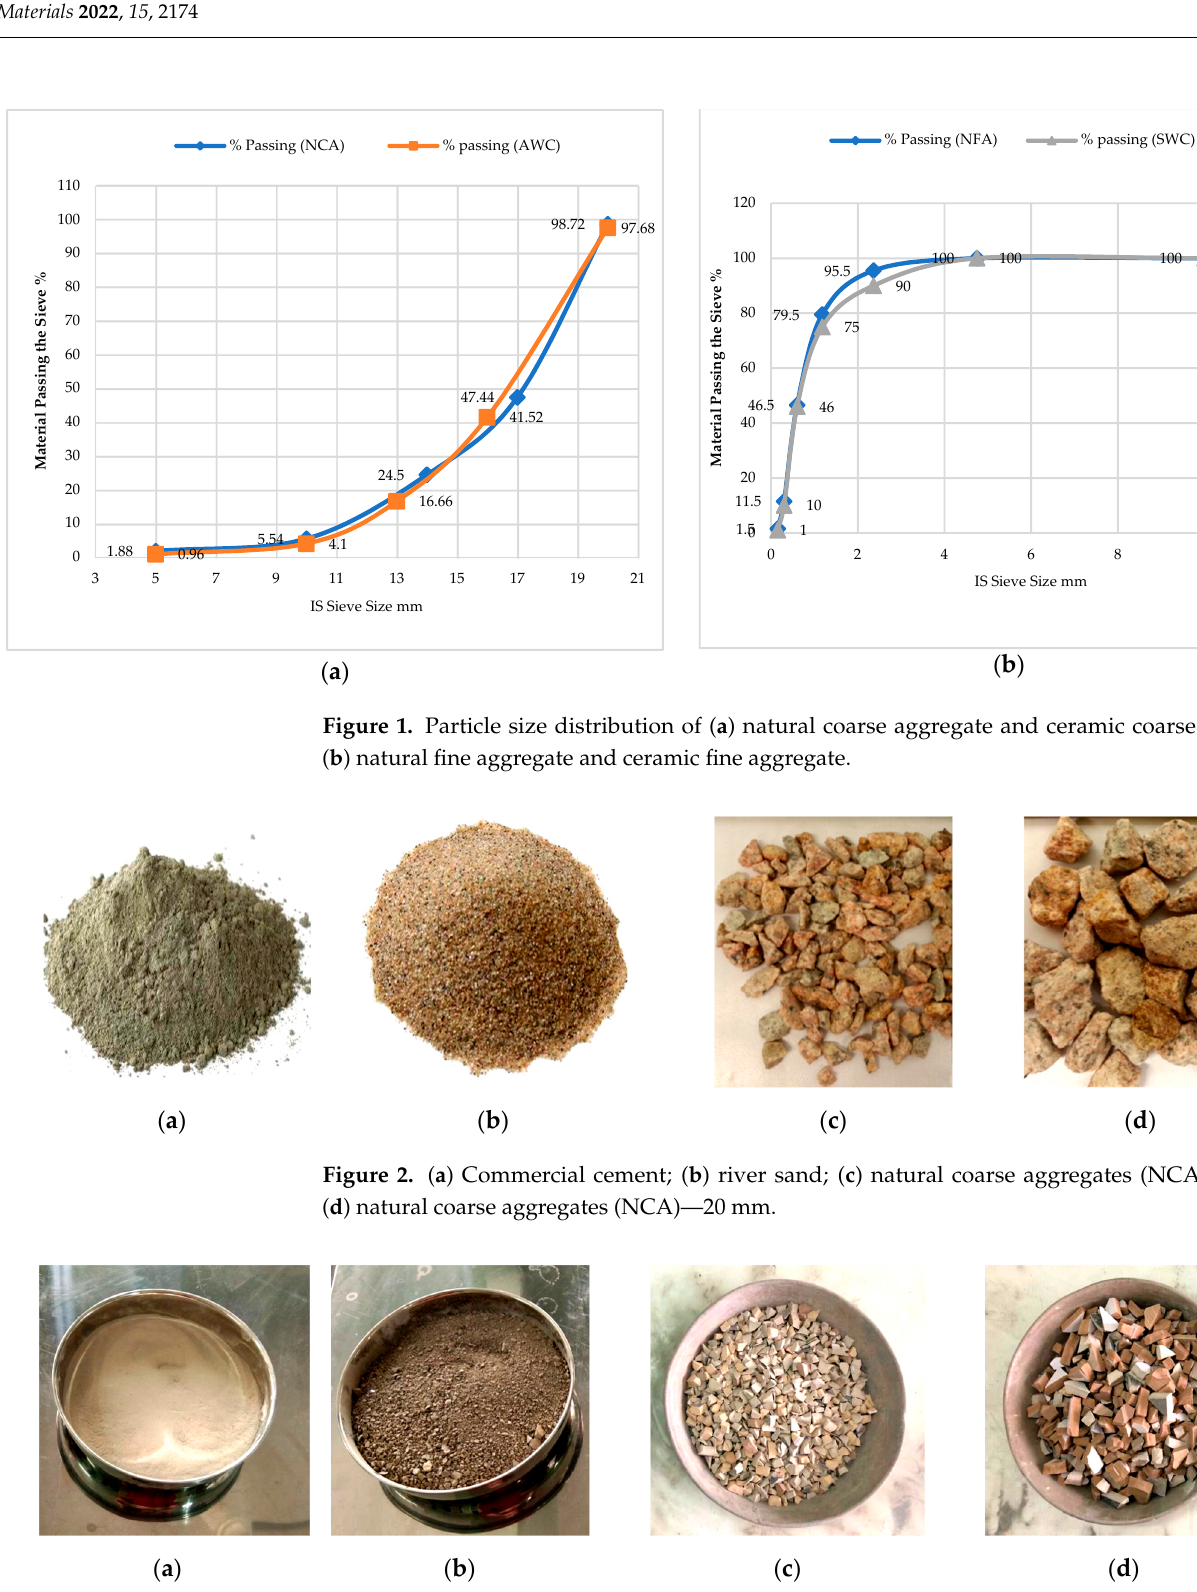
Figure 3. ( a ) Waste ceramic cement (C WC )—75 μ m; ( b ) waste ceramic sand (S WC )—4.75 mm ( c ) waste ceramic aggregate (A WC )—10 mm; ( d ) waste ceramic aggregate (A WC )—20 mm.